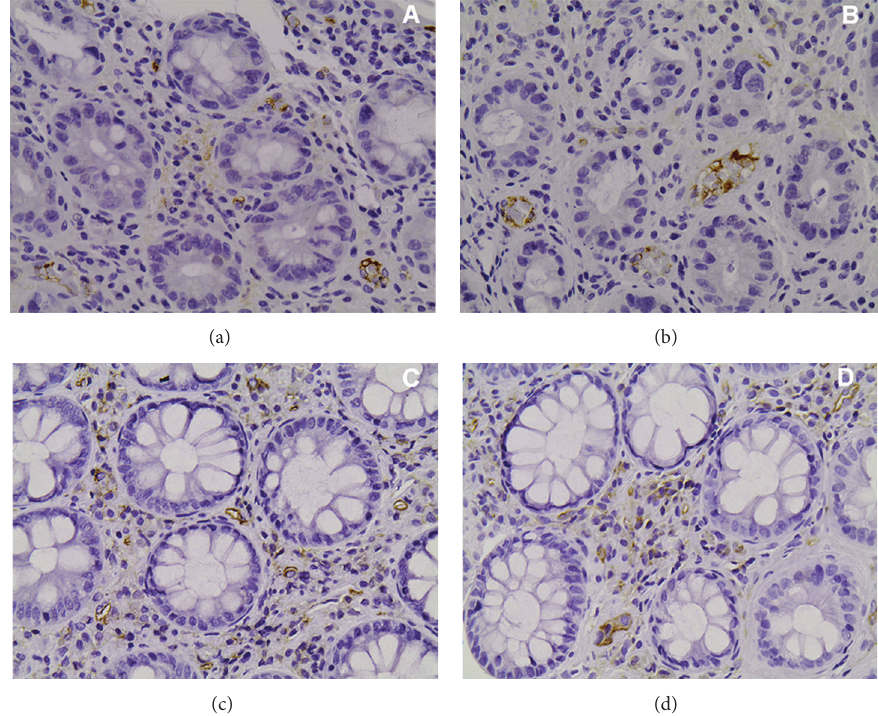
Figure 2: Rectal mucosa immunostained (a, b) with anti-VEGF antibody (M7273; Dako, Glostrup, Denmark) and (c, d) with anti-CD31 antibody (MO823; Dako, Glostrup, Denmark). Microvasculature was demonstrated by CD31 immunostaining of the vascular endothelial cells while VEGF was detected in endothelial cells and in few stroma cells showing cytoplasmic